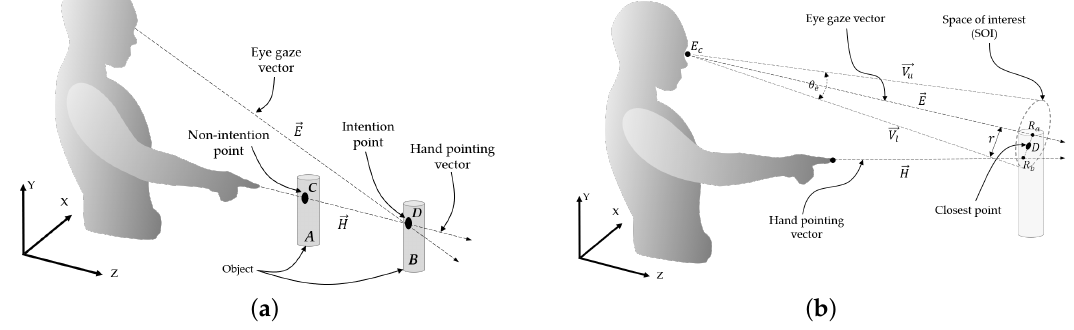
Figure 2. Human intention determined through the eye gaze and hand pointing: ( a ) Human intention through the eye gaze and hand pointing and ( b ) space of interest (SOI) and hand pointing during identification of